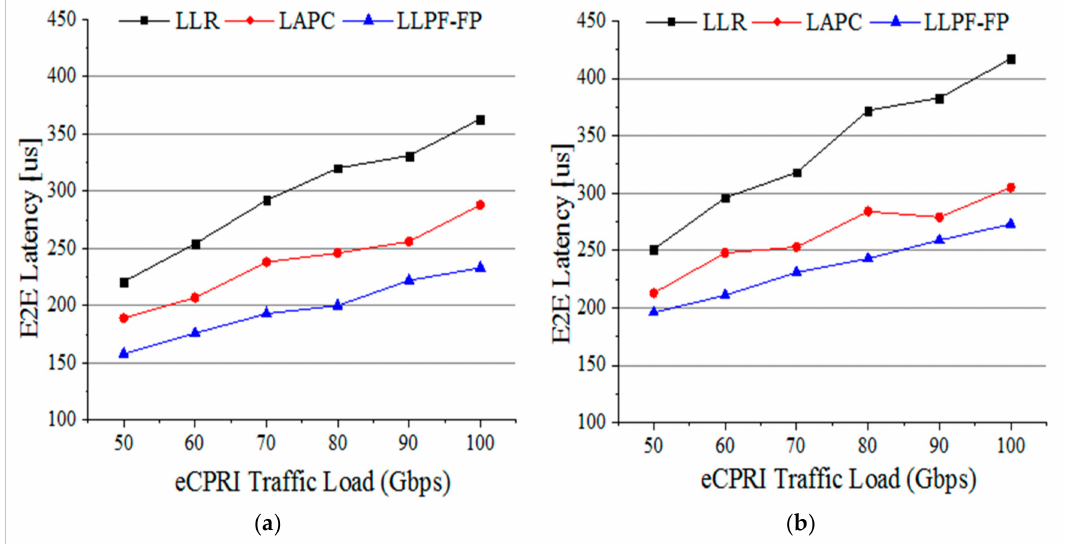
Figure 6. Performance results for worst-case end-to-end (E2E) latency for ( a ) COST239; and ( b )